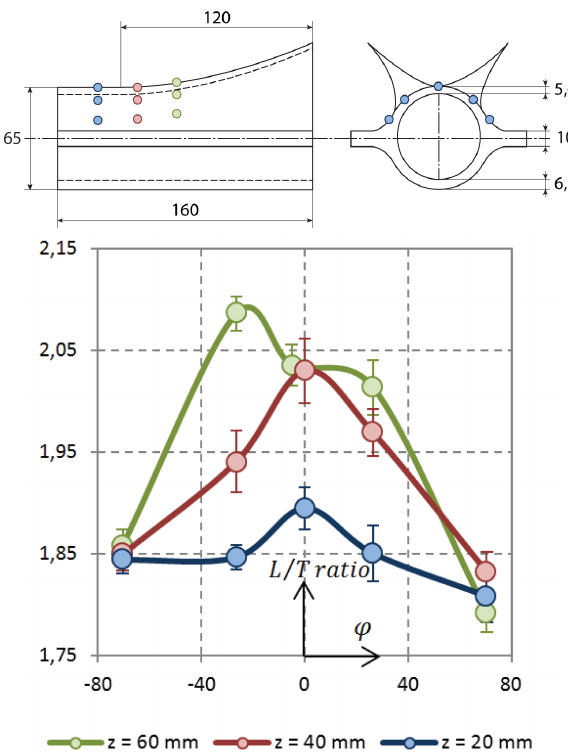
Figure 2. Sample subject to creep rupture with measured values of L/T ratio along the planes R1 (blue), R2 (red) and R3 (green). Connecting lines in the charts DO NOT provide any physical relation or a trend, they are for better orientation only